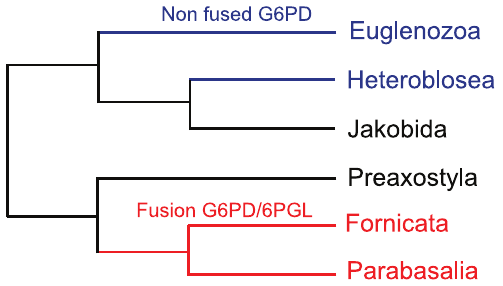
Figure 8. Phylogenetic tree of excavates. Adapted from [28]. The taxa in red contain a fusion between G6PD and 6PGL, while those in blue have non-fused copies of G6PD. The taxa in black have no fully sequenced genome and have no G6PD sequence available for analysis. The three taxa shown at the top form a proposed monophyletic group, Discoba, while the three on the bottom form the monophyletic group Metamonada. Note that the G6PD ortholog in Fornicata ( Giardia ) and that in Parabasalia ( Trichomonas ) appear to be derived from a bacterial gene transfer (see Figure 5).